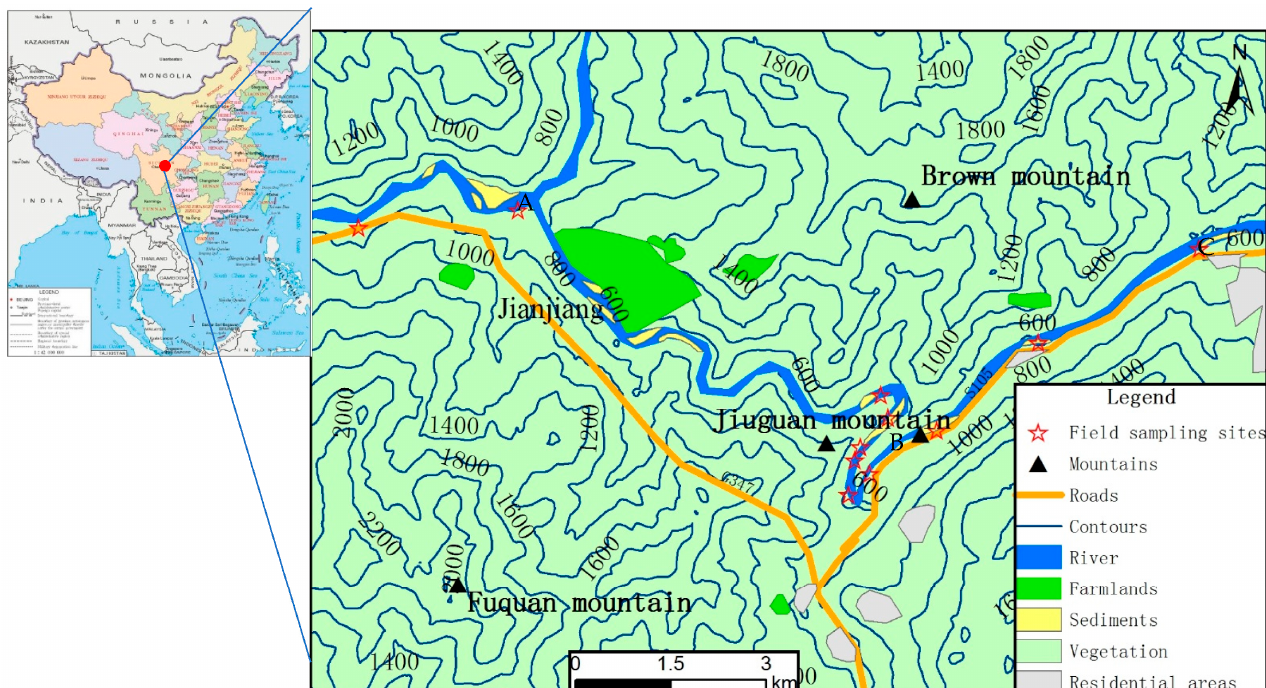
Figure 1. Location map of study area (map on the left shows the location of study area in China). According to the Köppen climate classification standard, the climate of the